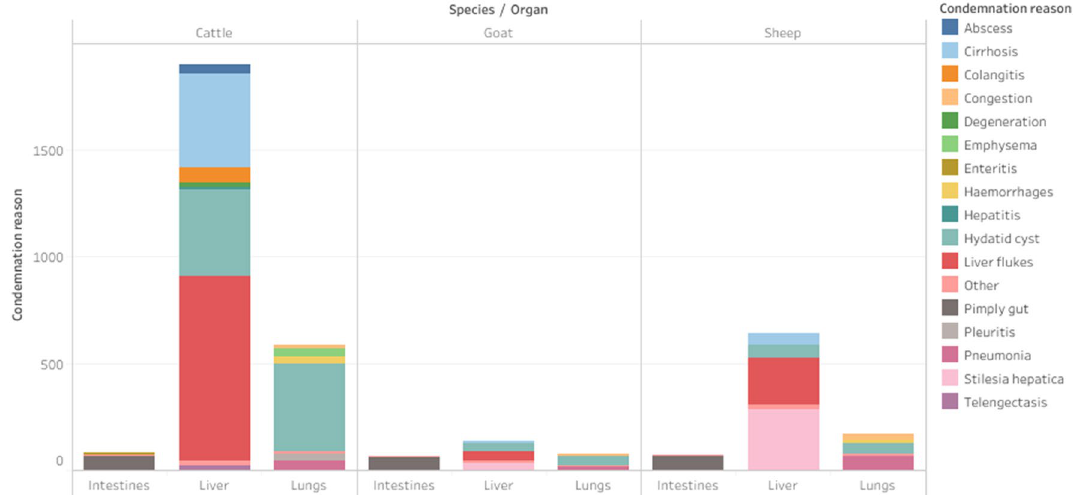
Figure 4. The reasons for condemnations of the intestines, liver, and lungs, and their frequency, in cattle, goats and sheep in two slaughterhouses in Bungoma County, western Kenya, between 17th March 2017 and 31st December